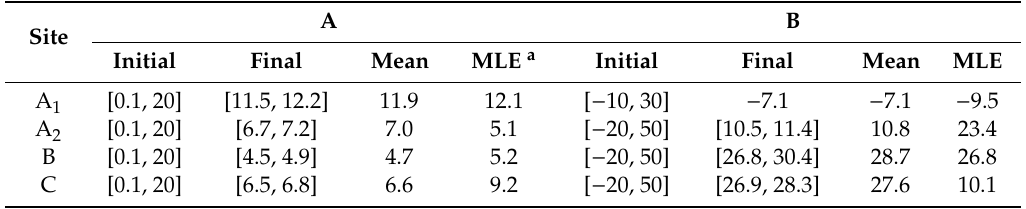
Table 1. Estimation results for the two parameters (A and B) in Model (20) under the four